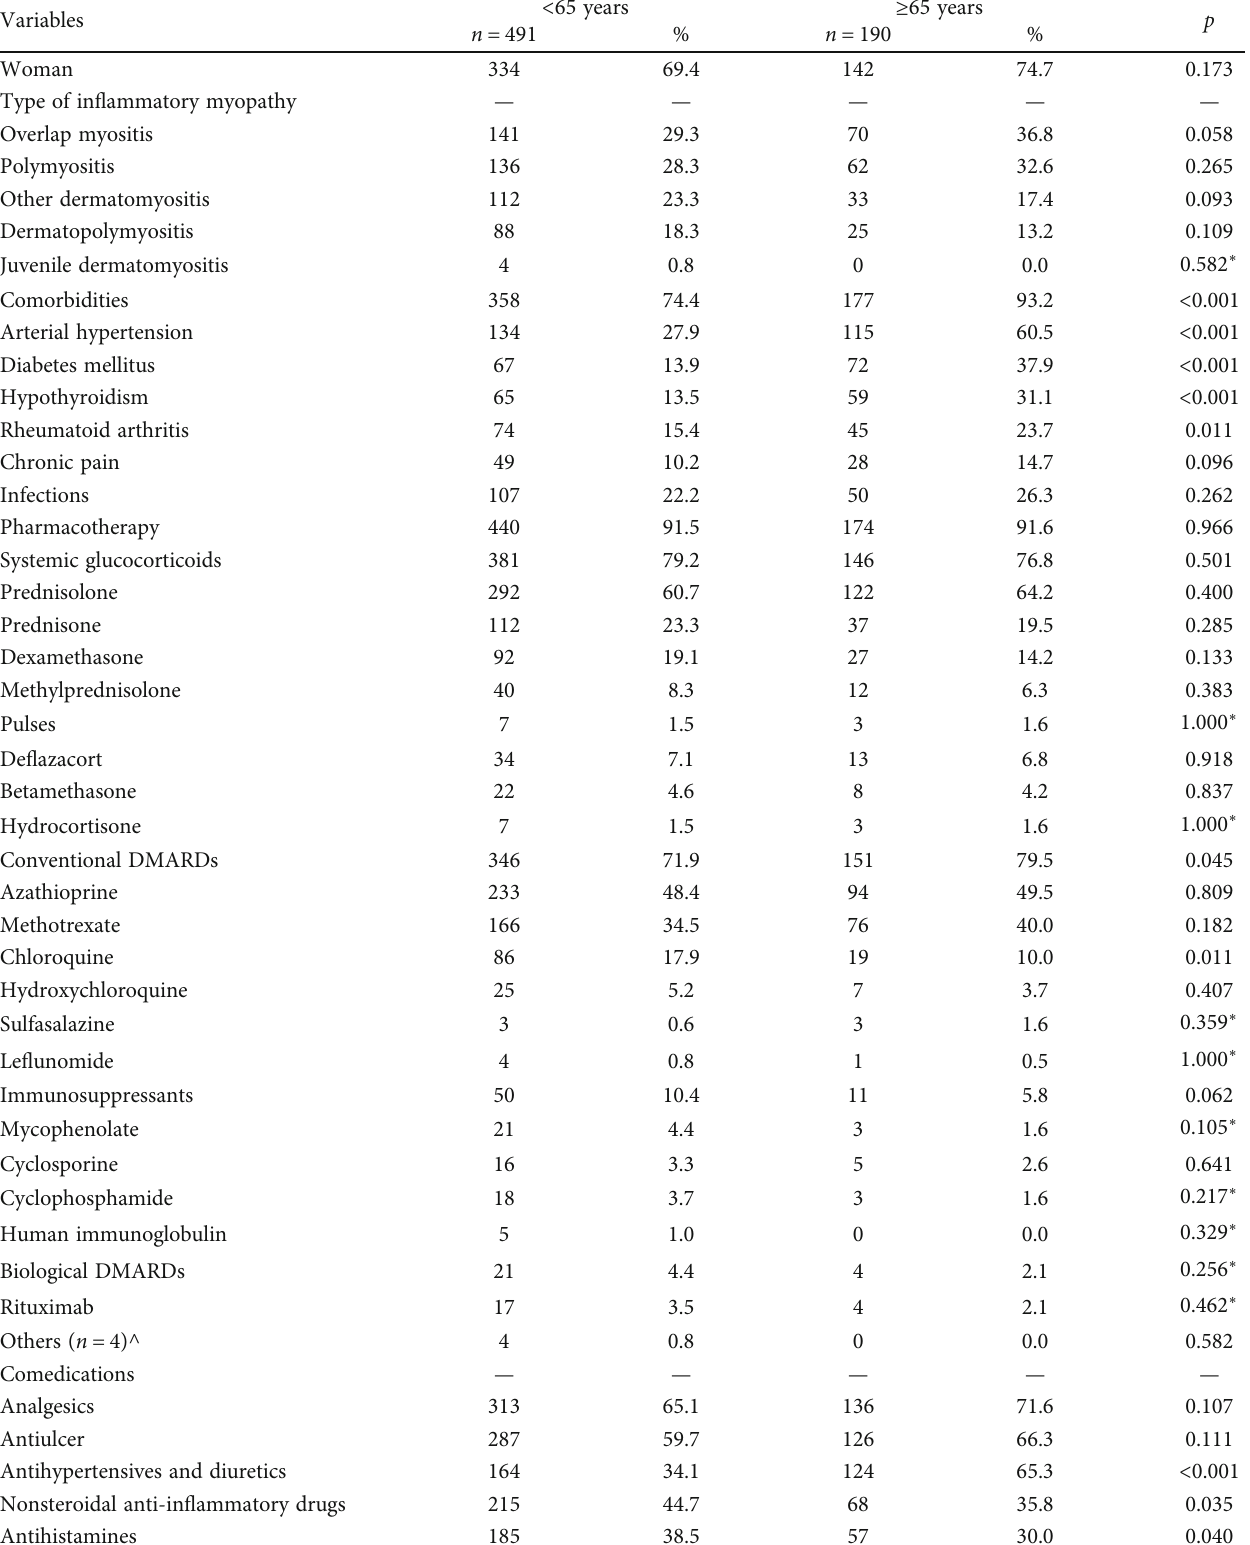
Table 3: Comparison of some sociodemographic and pharmacological variables between age groups of patients diagnosed with autoimmune idiopathic in fl ammatory myopathies in